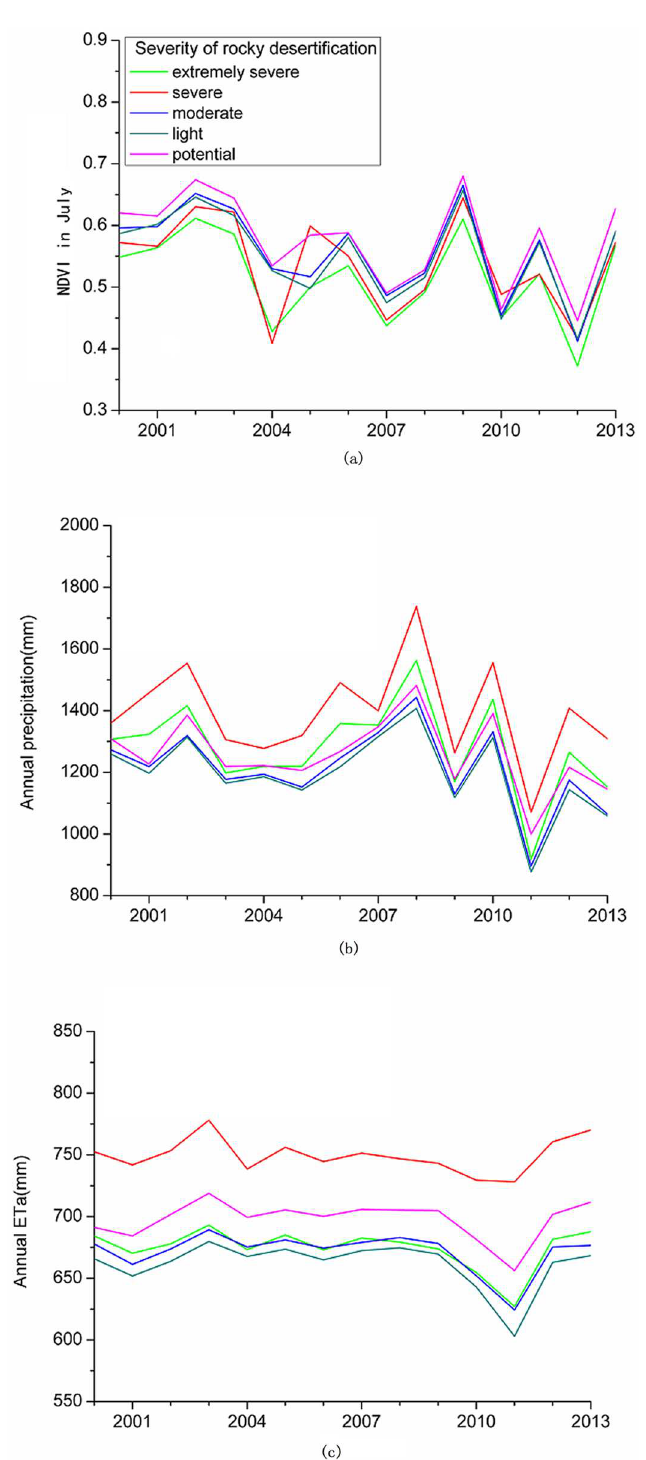
Fig 3. Annual variation of (a) NDVI in July, (b) actual evapotranspiration (ETa), and (c) average precipitation (P) in different severity categories of rocky desertification areas from 2000–2013.